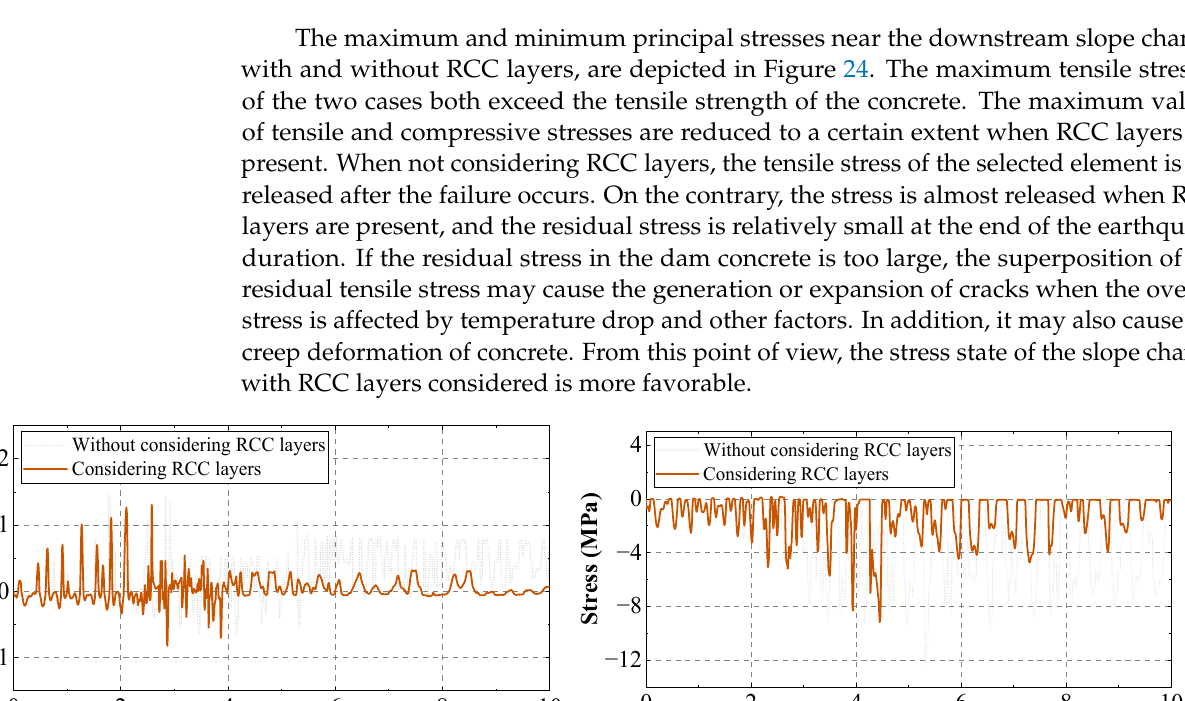
Figure 23. Displacement time histories of the dam crest. ( a ) Horizontal direction; ( b ) vertical direc- tion.